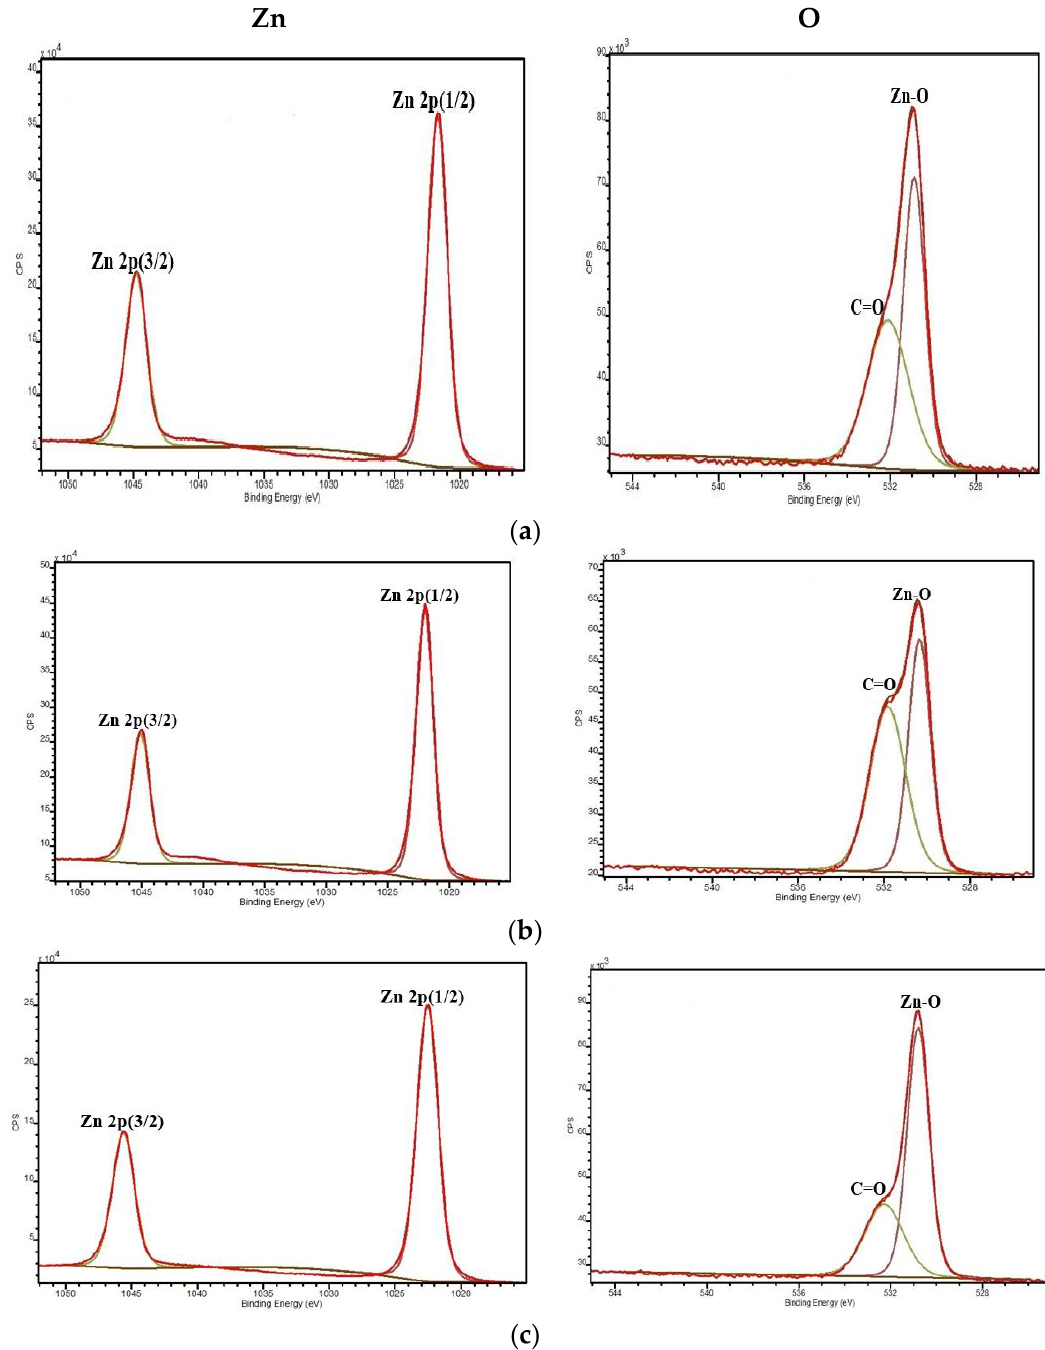
Figure 2. The principal XPS core levels of Zn and O. ( a ): substrate heated at 200°C, ( b ): substrate heated at 300°C, ( c ): substrate heated at 400°C.